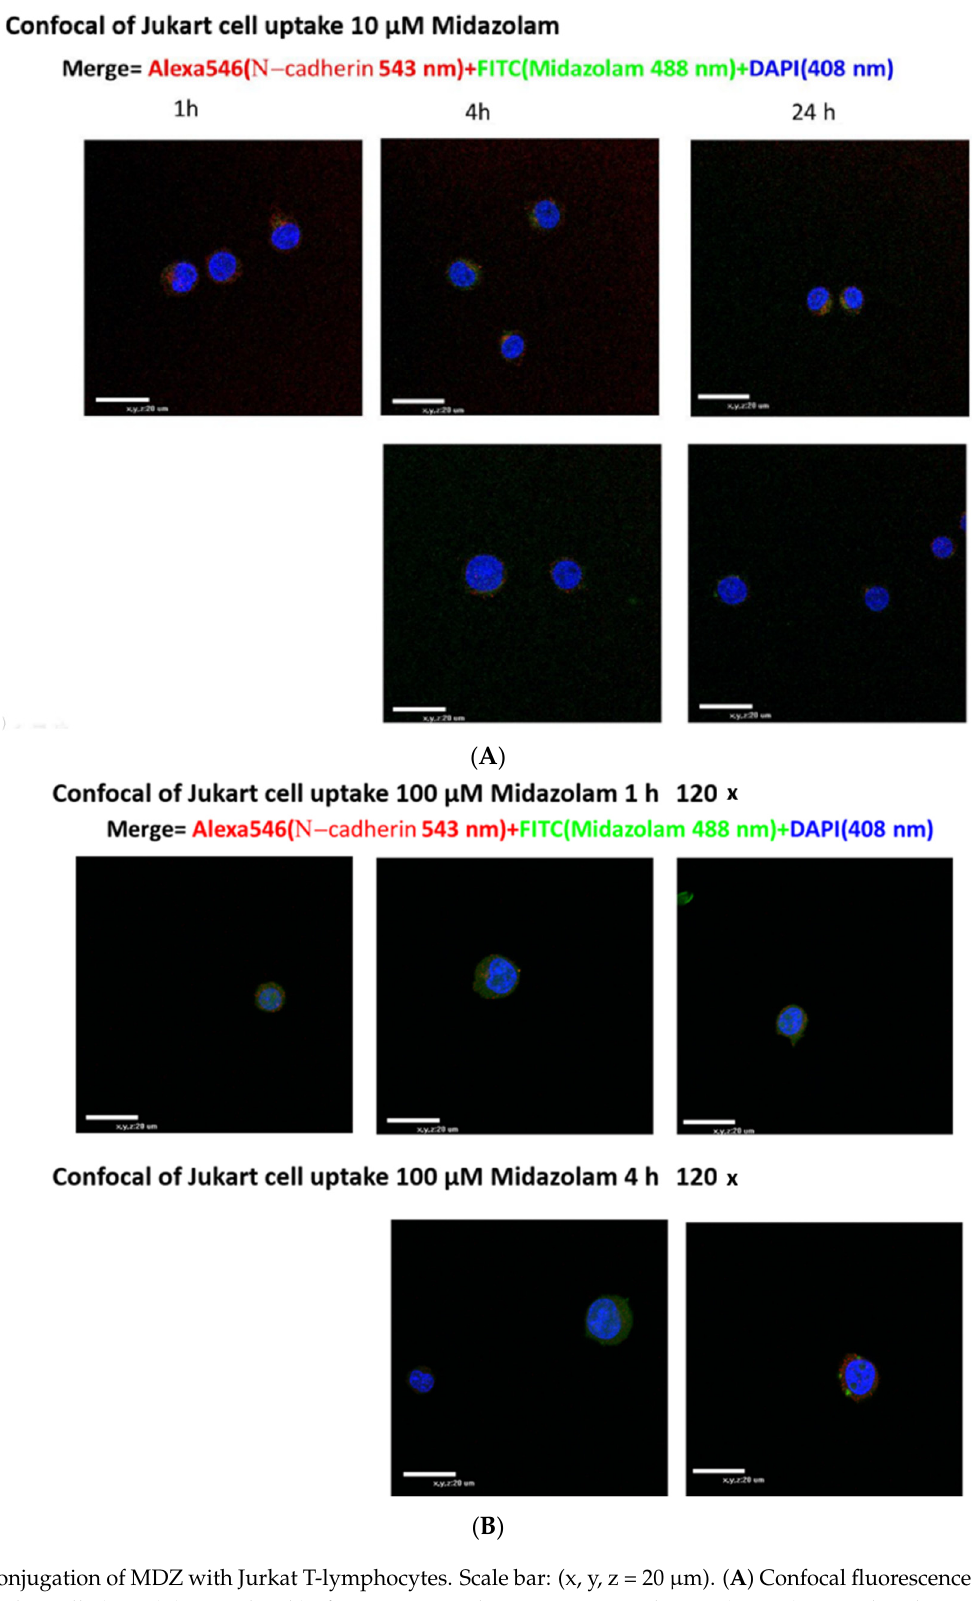
Figure 1. Conjugation of MDZ with Jurkat T-lymphocytes. Scale bar: (x, y, z = 20 µ m). ( A ) Confocal fluorescence microscopy picture of Jurkat cells (120×) (1, 4 and 24 h) after treating with FITC-conjugated MDZ (10 μ M) stained with Goat anti-rabbit Alexa-546 conjugated IgG. ( B ) Confocal of Jurkat cell (120×) after treating with FITC-conjugated MDZ (100 μ M) (1 and 4 h) stained with Goat anti-rabbit Alexa-546 conjugated IgG. The nucleus was stained with DAPI (showing nucleus) to show blue color while Alexa (red showing N-cadherin) and FITC (green showing MDZ) were found on the cell membrane. Co-localization of fluorescence dye was seen starting from 1, 4, and 24 h in both pictures.